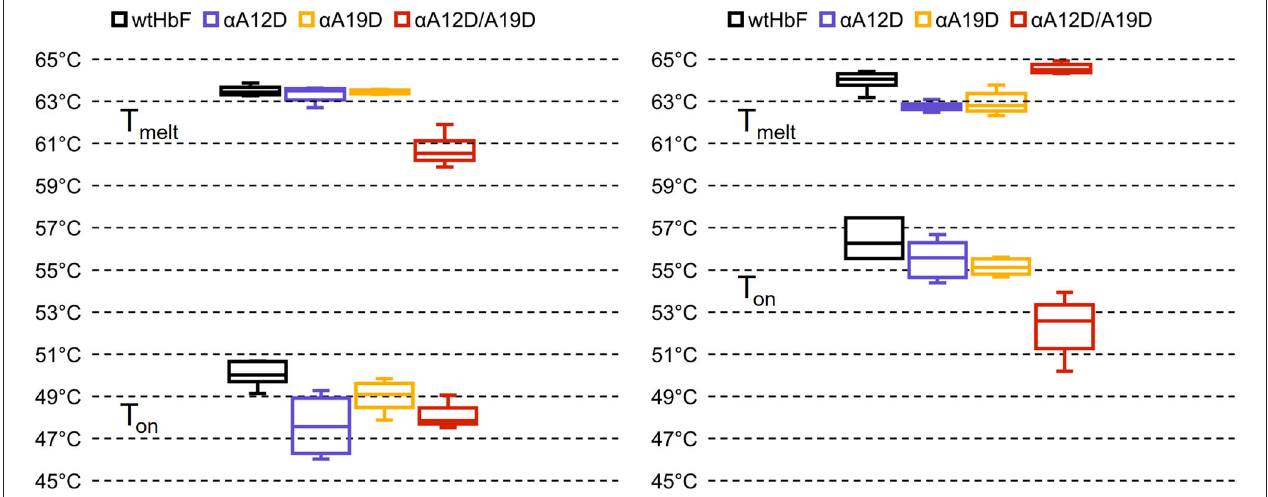
FIGURE 4 | Box plots of the onset and transition temperatures of ferric (Left) and ferrous (Right) samples of wtHbF, α A12D, α A19D, and α A12D/A19D, calculated from intrinsic fluorescence at 350:330nm ratio measured in a Prometheus NT.48 instrument (Nano Temper Technologies) over a temperature gradient. T on denotes the onset of unfolding while T melt signify transition temperature (50% unfolded). See Supplementary Figure 3 for the thermograms, and Supplementary Table 1 for independent t -test comparisons ( p <